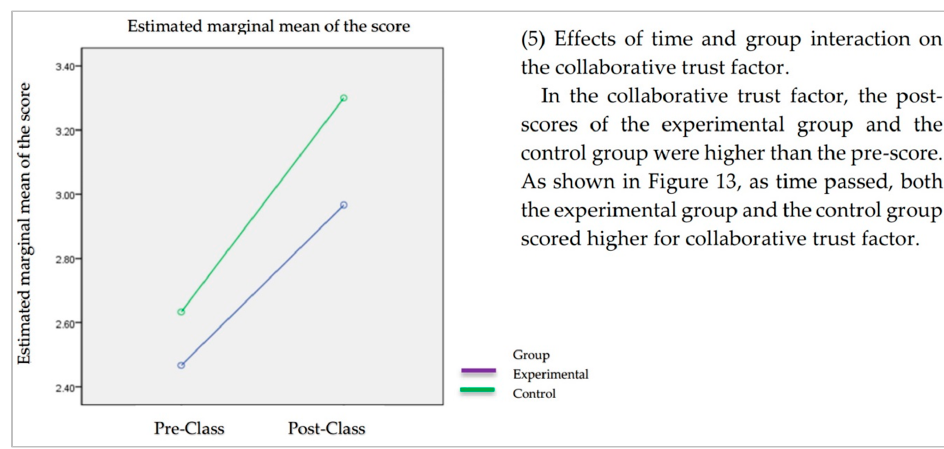
Figure 12. Effect of timing and group interaction on Mutual Relationship.